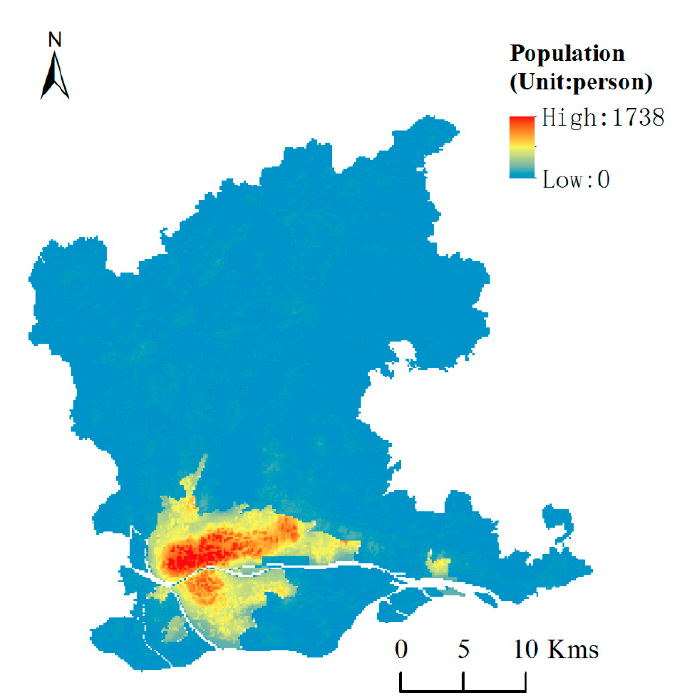
Figure 8. Population distribution map in the study area.